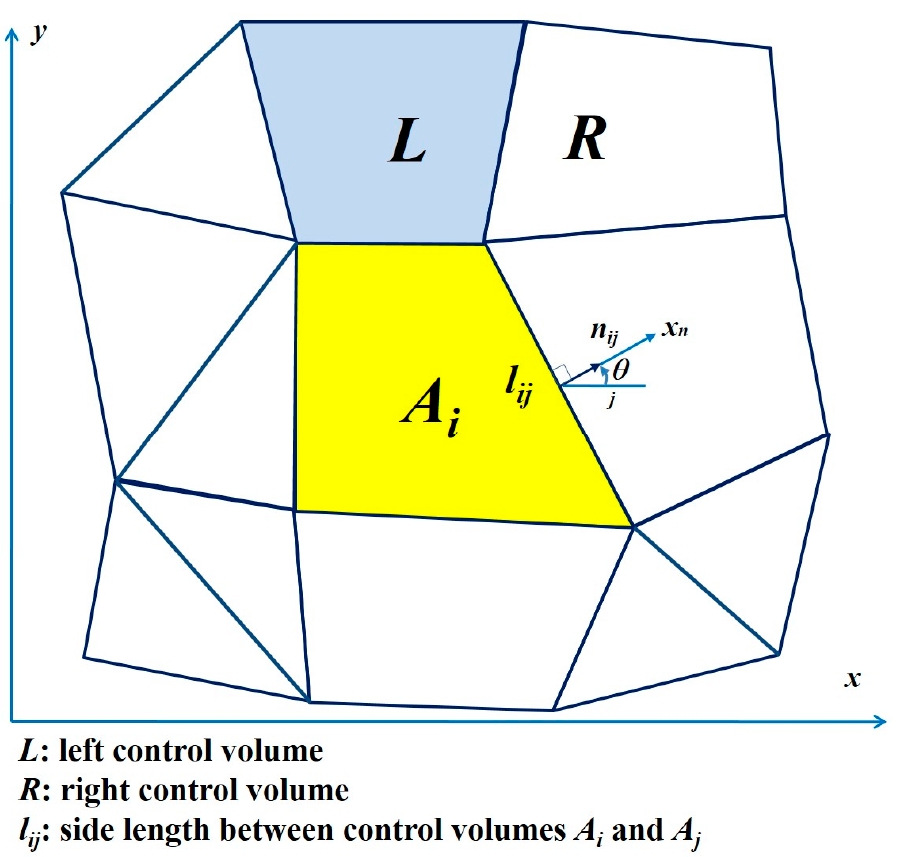
Figure 1. Triangular and quadrilateral cells in a two-dimensional unstructured grid system [22].